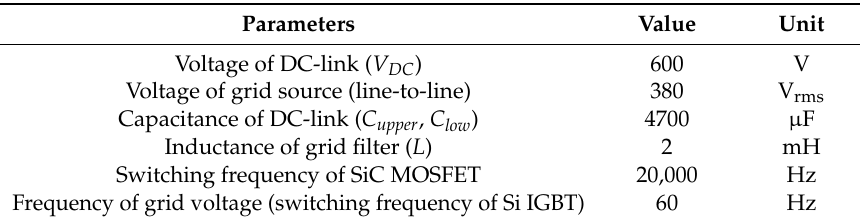
Figure 16. Experimental waveforms of phase current, current angle, and fault detection signals for each switch failure in the HANPC rectifier. Table 2. Parameters of HANPC rectifier.